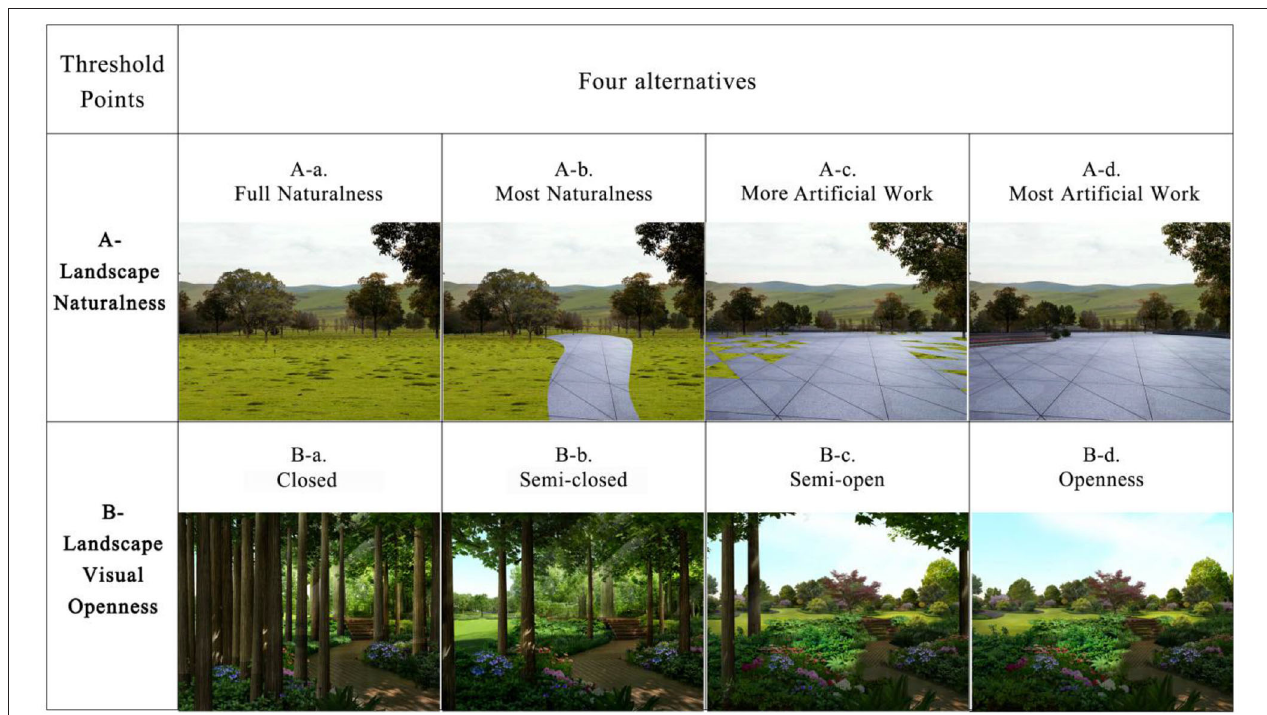
FIGURE 1 | Photographs in the questionnaire survey. (1) The four alternatives (a–d) in group A were divided based on an estimate of the area of naturalness in the pictures: (A-a) is < 5% of the artificial work, (A-b) is about 5–25% of the artificial traces, (A-c) is about 25% − 55% of the artificial work, and (A-d) is about 55–75% of the artificial work; (2) The four alternatives (a–d) in group B were divided by the landscape’s visual openness. The four degrees of a/b/c/d in group B were estimated according to the depth/high [D/H] of the site in the photos. (B-a) is D/H ≤ 1, (B-b) is 1.5 > D/H > 1, (B-c) is 2 > D/H > 1.5, and (B-d) is D/H >